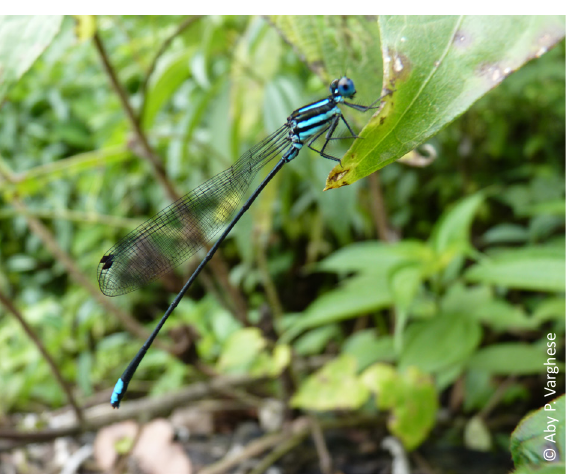
Image 17. Protosticta sanguinostigma